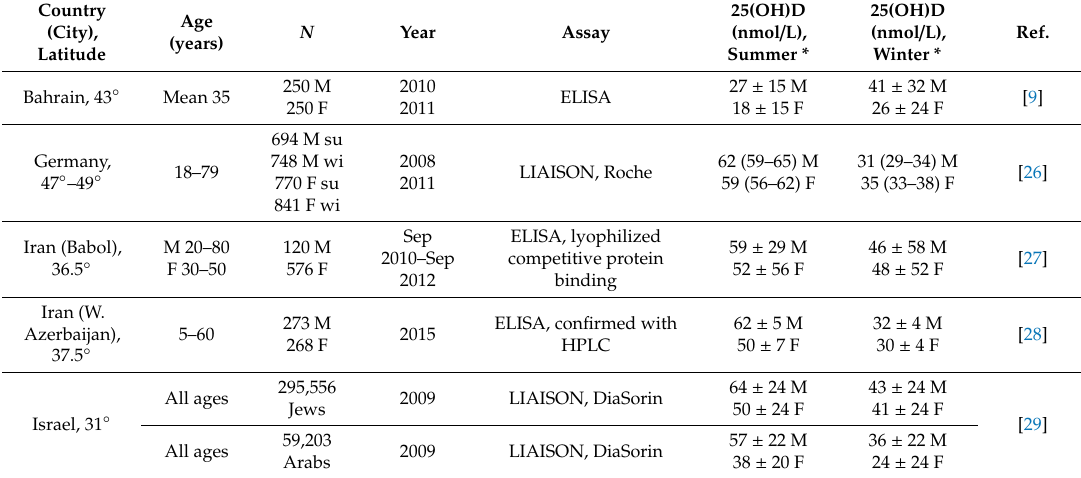
Table 1. 25-hydroxyvitamin D (25(OH)D) concentration data used in this study for the set of 15 countries from the Middle East and